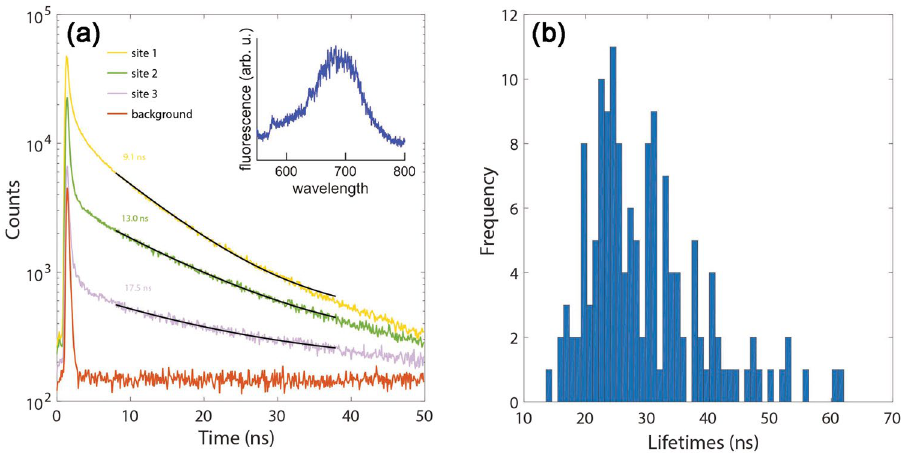
Figure 3. ( a ) Fluorescent decay traces from three different sites and a background measurement. The black lines are single exponential fits (presented for simplicity although multiple exponential fitting analysis was performed), and the values are the calculated average lifetimes of all the NV centre emission at that particular site. The inset is an example of a spectrum acquired, used to distinguish between sites that held NV centres and those that did not. ( b ) A histogram of the lifetimes obtained from the fluorescence time series fits. The data set contained 153 fluorescent sites from a total of 220 analysed sites, and the lifetimes were calculated with a sum of weighted exponentials. We discarded lifetimes close to 5 ns and 100 ns as being artefacts of the fitting routine. The modal fluorescence lifetime was 24.5 ns, with a strongly asymmetric distribution towards longer lifetimes. As expected, all of the measured lifetimes were greater than the spontaneous emission lifetime of NV centres in bulk